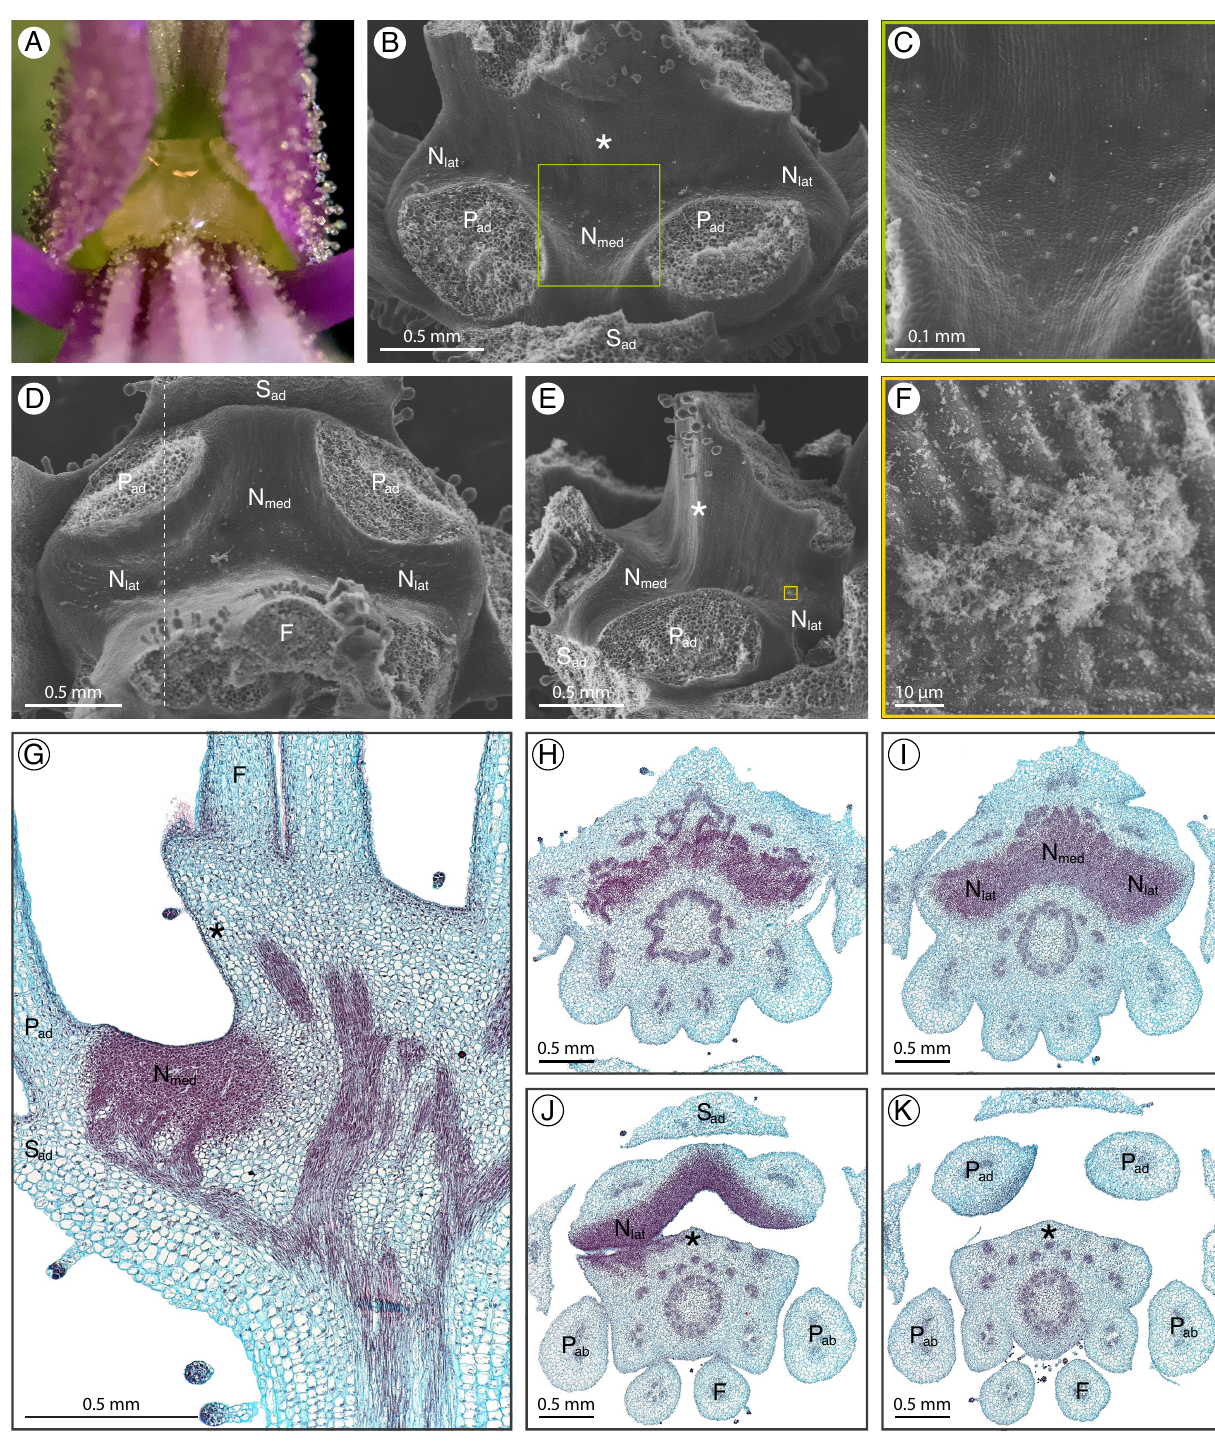
Figure 8. Sieruela hirta nectary ( A ) photograph, ( B – F ) scanning electron micrographs, and ( G – K ) fast green and safranin O-stained sections. ( A ) Apical view of the nectary. ( B ) Adaxial view of the nectary. ( C ) Adaxial view close-up of the nectary, corresponding to the box in ( B ). ( D ) Apical view of the nectary. ( E ) Lateral view of the nectary. ( F ) Lateral view close-up of the nectary, corresponding to the box in ( E ). ( G ) Longitudinal section (sagittal plane) of the intermediate stage nectary, corresponding to the dashed line in ( D ). ( H – K ) Transverse sections of the nectary from proximal to distal orientation. All images are of anthetic stage specimens unless indicated otherwise. Basal fusion of adaxial filaments is indicated with an asterisk. F: filament; N lat : lateral nectary lobe; N med : medial nectary lobe; P ab : abaxial petal; P ad : adaxial petal; S ad : adaxial